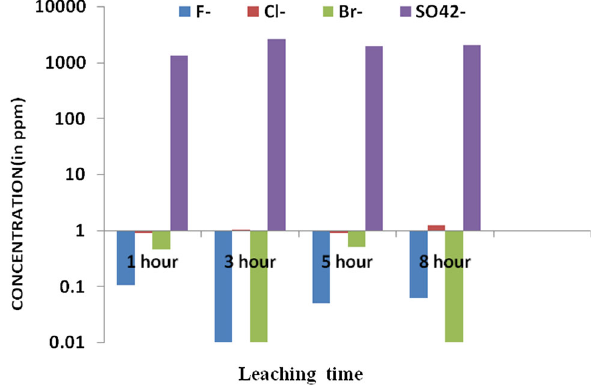
Fig. 17 Change in concentration (in ppm) of anions in aqueous leachates of Ledo overburden (LOB-15A) with leaching time (in hour) at 45 (cid:3) C